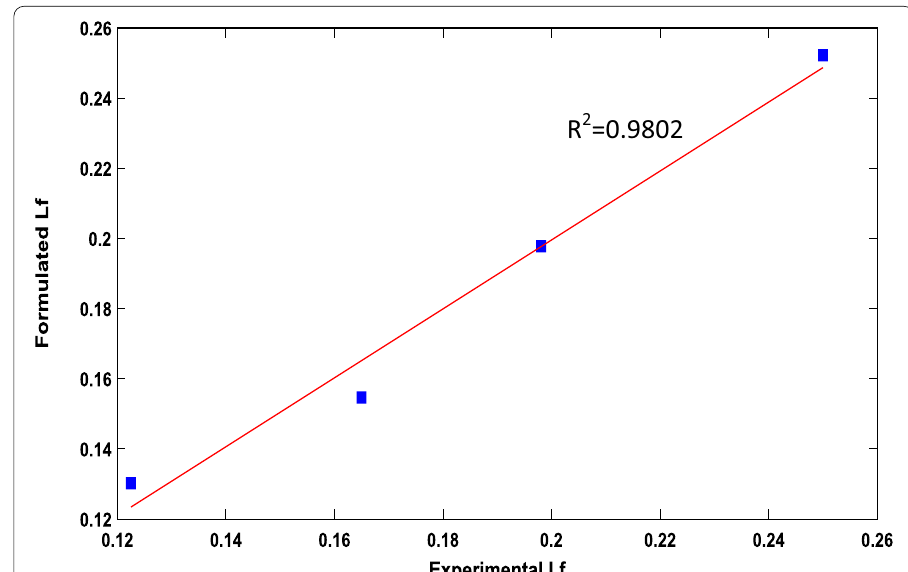
Fig. 17 Scatter plot for L f in single pile in forward loading